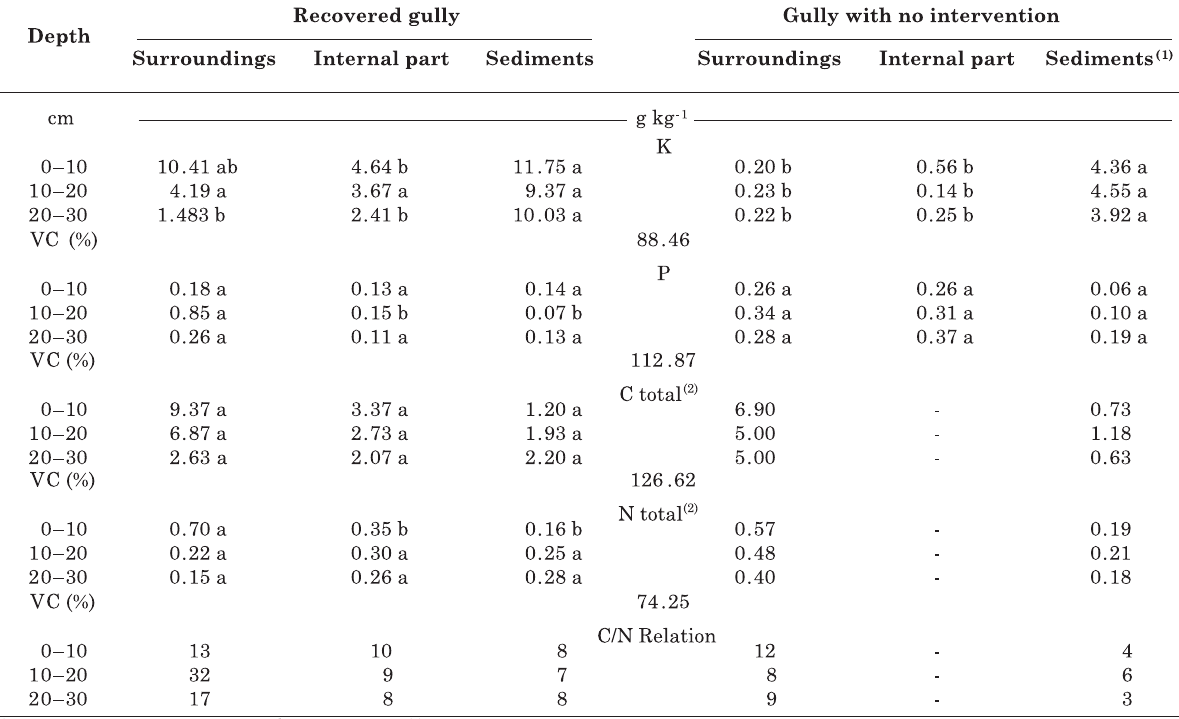
Table 5. Pseudo-total and total contents of nutrients in the surroundings (mid-third), interior and sediments of the recovered gully and the gully without